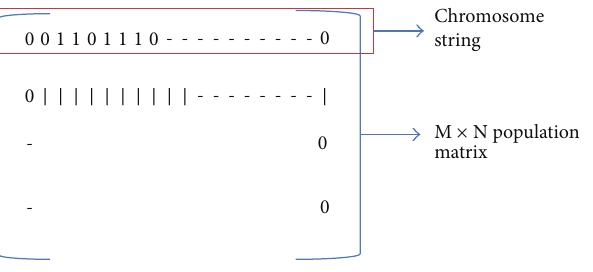
Figure 3: Sample space for